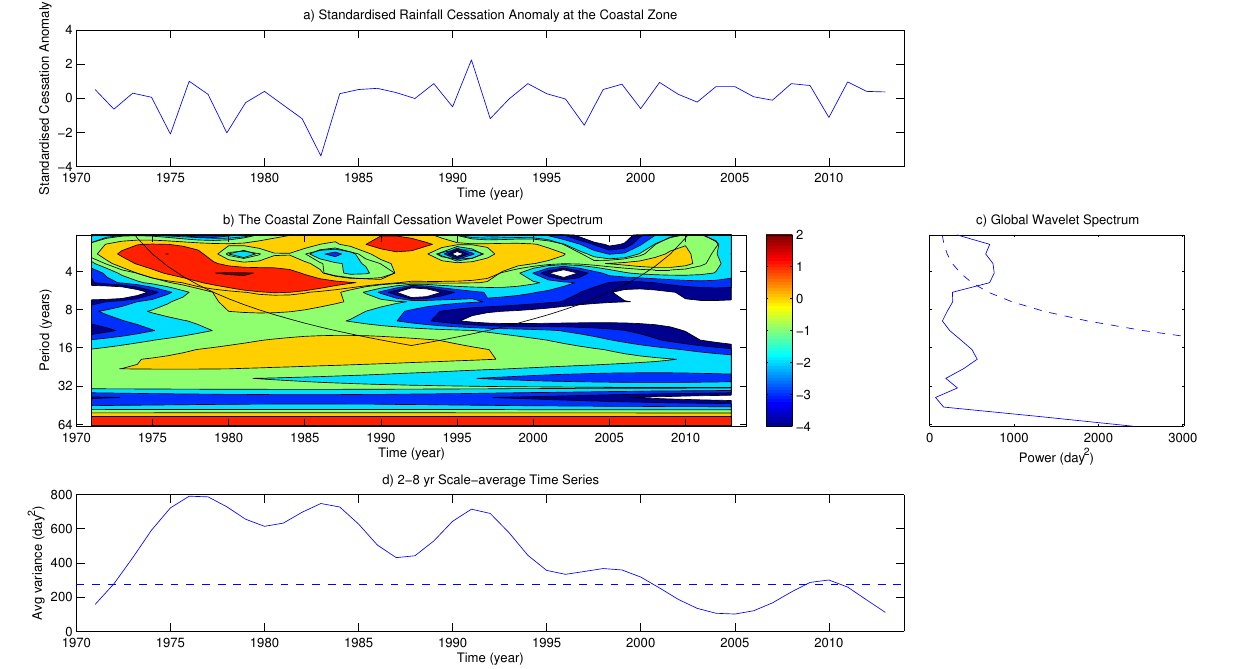
Figure 13. Interannual variability of rainfall cessation dates for the coastal zone using wavelet analysis. ( a ) Standardized anomaly of cessation; ( b ) the same as in Figure 6, but for cessation; ( c ) the same as in Figure 6; ( d ) as in Figure 6; the dashed line shows the 95% confidence